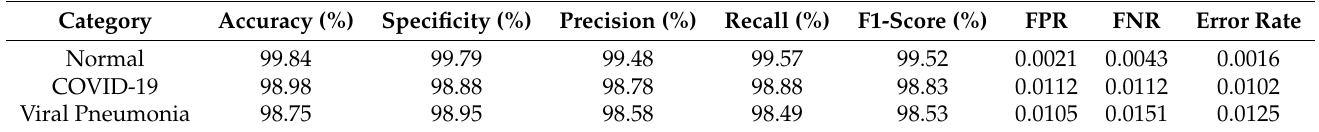
Table 9. Performance measures for ResNet-50 after optimization for X-ray images.